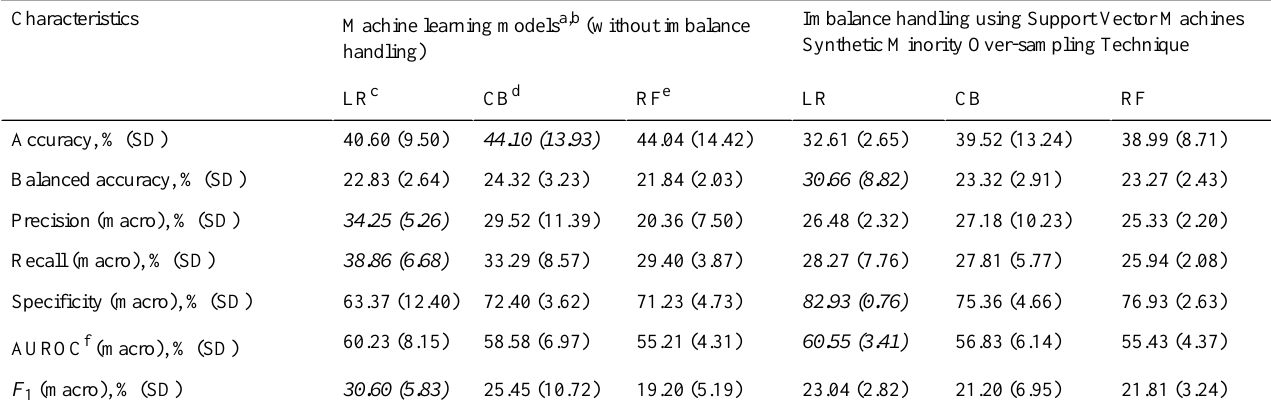
Table 3. Results of the general models for emotional state detection on the basis of a six-fold, leave-3-people-out cross-validation.